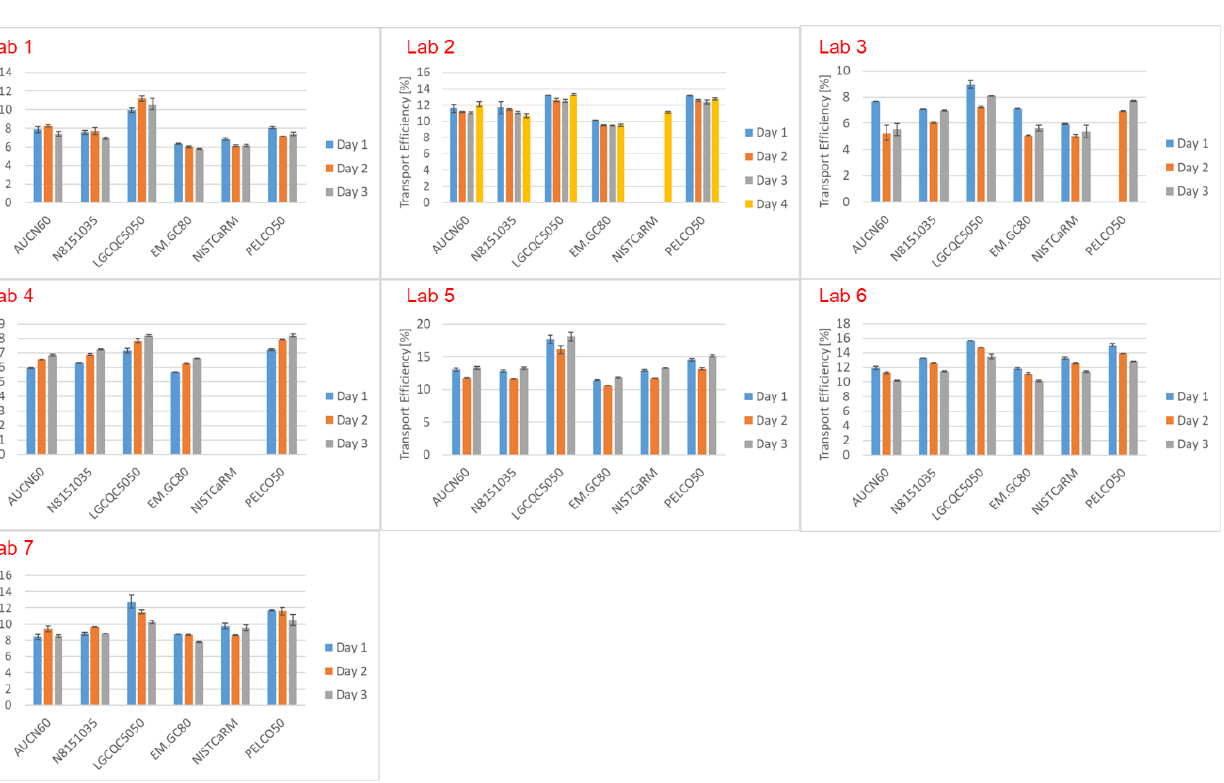
Figure 5. Transport efficiencies based on measured particle size (TES) determined on different days. Another trend that can be observed is that the obtained transport efficiencies do generally match well independently of which AuNP was used, except when using product LGCQC5050. Here the transport efficiencies were systematically higher for all laboratories by 0.17% to 6.05% (average values for all laboratories and all measurements). More detailed statistical analysis is summarised in Table S9